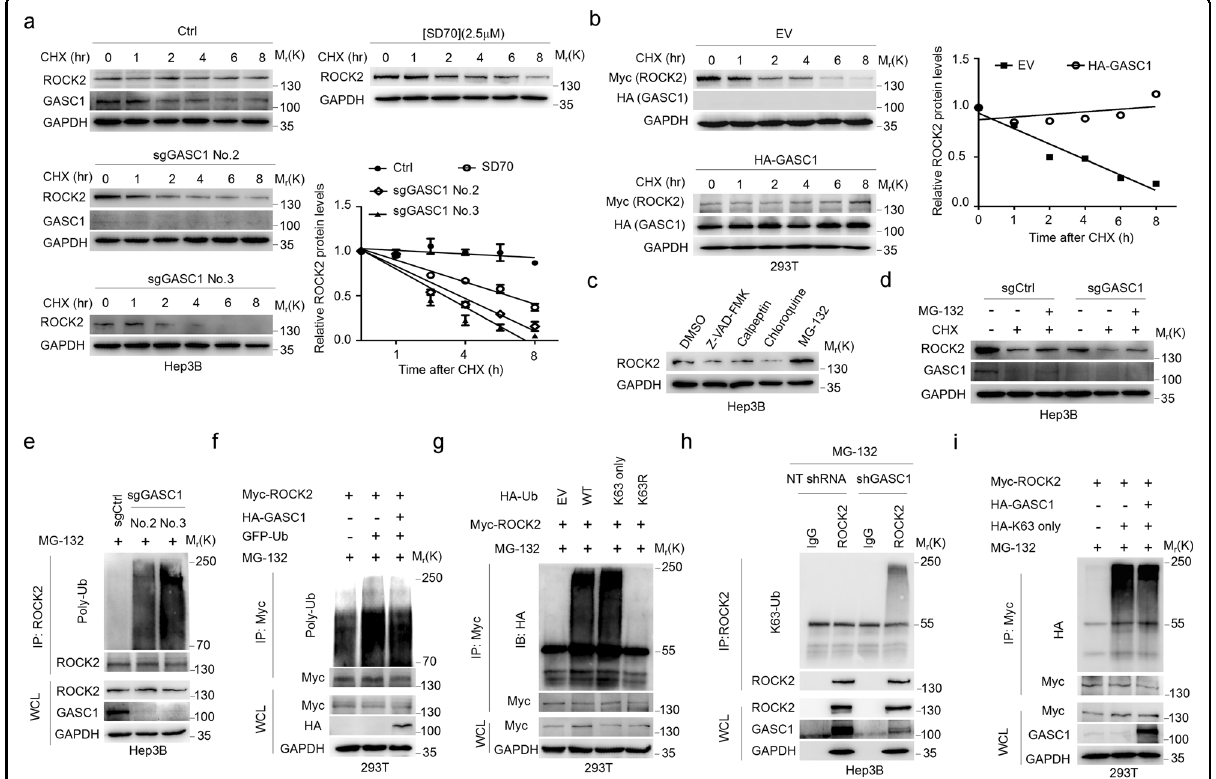
Fig. 4 GASC1 stabilizes ROCK2 through preventing K63-linked poly-ubiquitination. a Immunoblotting (IB) analysis of ROCK2 stability in Hep3B GASC1-KO clones or WT cells treated with SD70 for 36 h. Where indicated, 100 μ g/ml cycloheximide (CHX) was added, and cells were harvested for IB analysis at the indicated time points. The ROCK2 protein abundance was quanti fi ed by Image J and plotted in the graph. b IB analysis of ROCK2 stability in HEK293T cells transfected with the indicated plasmids. Cells were treated with 100 μ g/ml CHX for the indicated time period before harvesting (left panel). The Myc-tagged (ROCK2) protein abundance was quanti fi ed by Image J and plotted as in the graph. EV empty vector. c IB analysis of ROCK2 protein levels in PLC/PRF/5 cells after treatment with 10 μ M chloroquine, calpeptin, Z-VAD-FMK, or MG-132 for 24 h before harvesting. d IB analysis of ROCK2 protein levels in Hep3B cells with GASC1 depletion. Cells were treated with or without 100 μ g/ml CHX and 10 μ M MG-132 for 8 h before harvesting. e IB analysis of ROCK2 poly-ubiquitination in GASC1 knockout Hep3B cells. Cells were treated with 10 μ M MG-132 for 6 h before harvesting. f IB analysis of ROCK2 poly-ubiquitination upon HA-GASC1 overexpression in HEK293T cells. Cells were treated with 10 μ M MG-132 for 6 h before harvesting. g Signi fi cant levels of ROCK2 poly-ubiquitination can be detected by IB in cells transfected with wide-type ubiquitin or lysine-63-linked ubiquitin (K63 only), but not with lysine-63-arginine mutant ubiquitin (K63R) constructs. Cells were treated with 10 μ M MG-132 for 6 h before harvesting. h GASC1 knockdown increases K63-linked poly-ubiquitination of ROCK2 in Hep3B cells. Cells were treated with 10 μ M MG-132 for 6 h before harvesting. i Poly-ubiquitination of ROCK2 inversely correlated with GASC1 ectopic expression. IB analysis of WCL and anti-Myc IP products derived from HEK293T cells transfected with HA-GASC1, Myc-ROCK2, and HA-Ub constructs. Cells were treated with 10 μ M MG- 132 for 6 h before